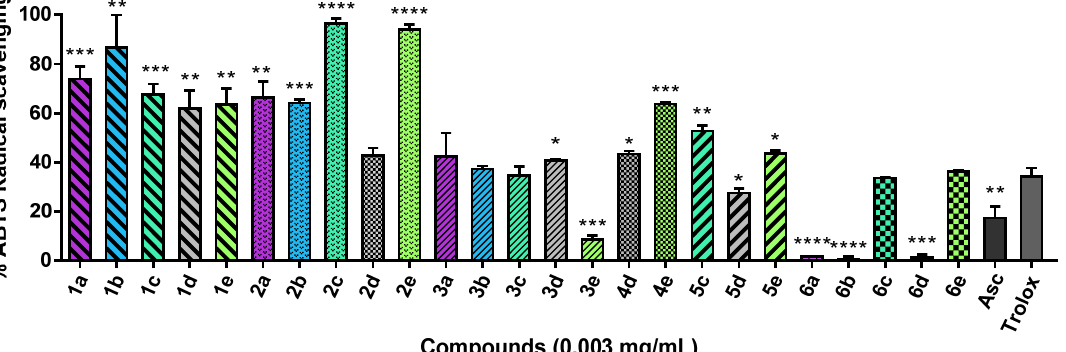
Figure 3. ABTS radical scavenging activity, expressed as percentage, for the selenoureas presented herein. ABTS • + scavenging after 60 min of treatment at 0.003 mg/mL. Selenoureas 4a , 4b , 4c , 5a , and 5b were degraded before the DPPH assay was realized. Significance: * p < 0.05, ** p ≤ 0.01, *** p ≤ 0.001 and **** p ≤ 0.0001 compared with Trolox. Results obtained for other times and concentrations are included in the Supplementary Material (Figures S101–S106).